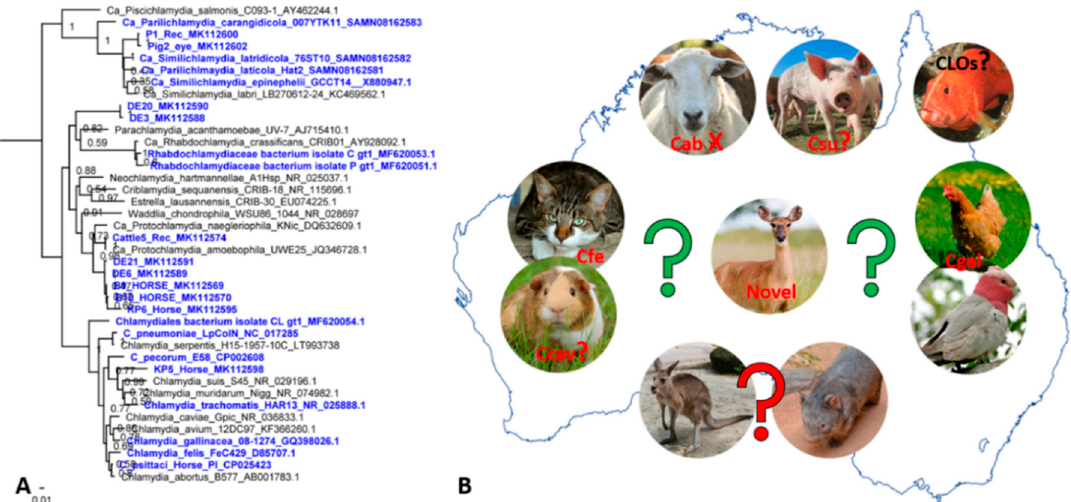
Figure 2. Genetic diversity of chlamydial infections in an expanded host range in Australia. ( A ) a mid- point rooted maximum likelihood phylogenetic tree constructed using an alignment of the 298bp “chlamydial” signature fragment of the 16S rRNA gene from the publicly available sequences from Genbank. Support values are shown on the major nodes. Phylogenetic positioning of taxa described in Australian hosts are highlighted in bold and blue. ( B ) Schematic representation of an expanded range of animal hosts for chlamydial infections, where X denotes exotic chlamydial species (e.g., Chlamydia abortus ), red question marks indicate no or anecdotal infection or hosts reports (e.g., Chlamydia caviae and Chlamydia suis, wombats and kangaroos), and green and black (for chlamydia- like organisms (CLO) in fish) question marks indicate scarce reports in the denoted hosts and mainly unknown